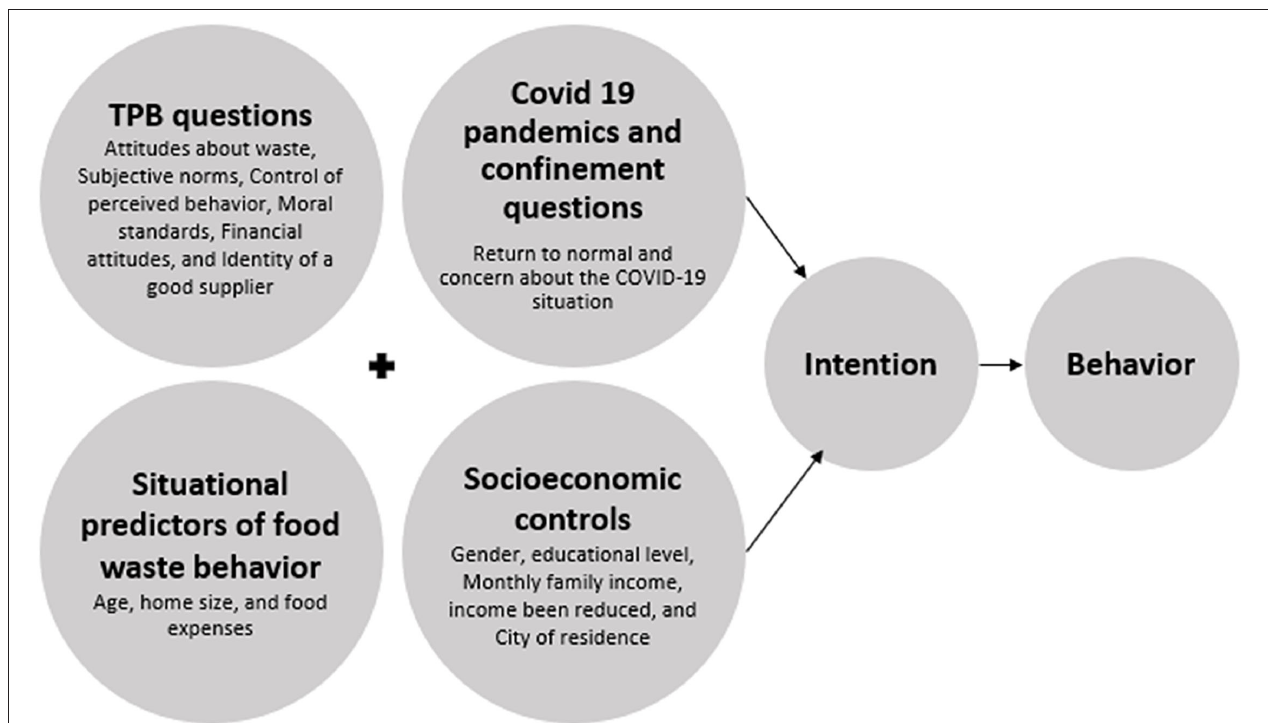
FIGURE 1 | Overview on the dimensions used to predict food waste intention and behavior . Source: own